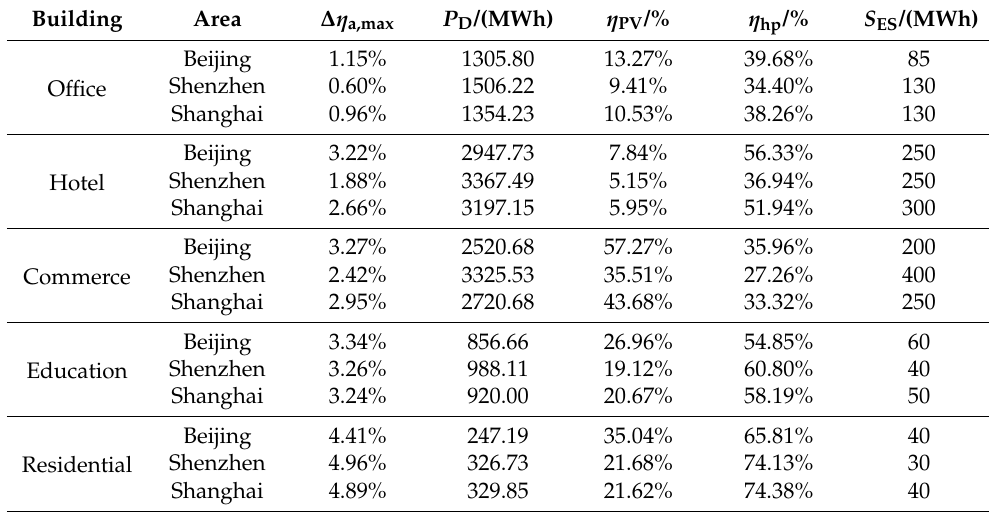
Table 7. Energy efficiency calculation data for 15 different